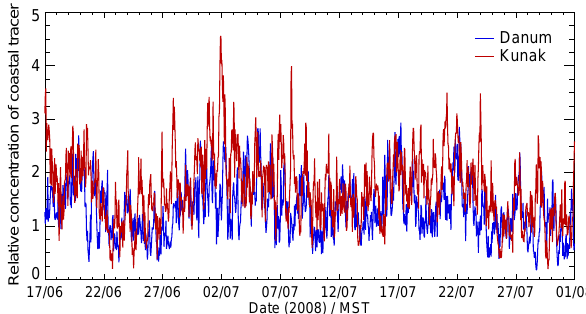
Fig. 6. Time series of the total tracer concentration for the lowest 100m of 0.2 ◦ squares (see Fig. 5 inset) centred on Danum (blue) and Kunak (red). Each of the emitted particles is initialised in the model with an arbitrary mass, in this case of CHBr 3 -like tracer. We normalise the mean modelled particle concentration at Danum to the mean of our CHBr 3 measurements at Danum (1.31ppt). The same scaling factor is applied to the modelled particle concentration at Kunak and the vertical axis then gives absolute mixing ratios inppt. Finally, we scale the mass emitted on each particle to obtain our emission rate of 1.3Gg CHBr 3 /yr from the upwind